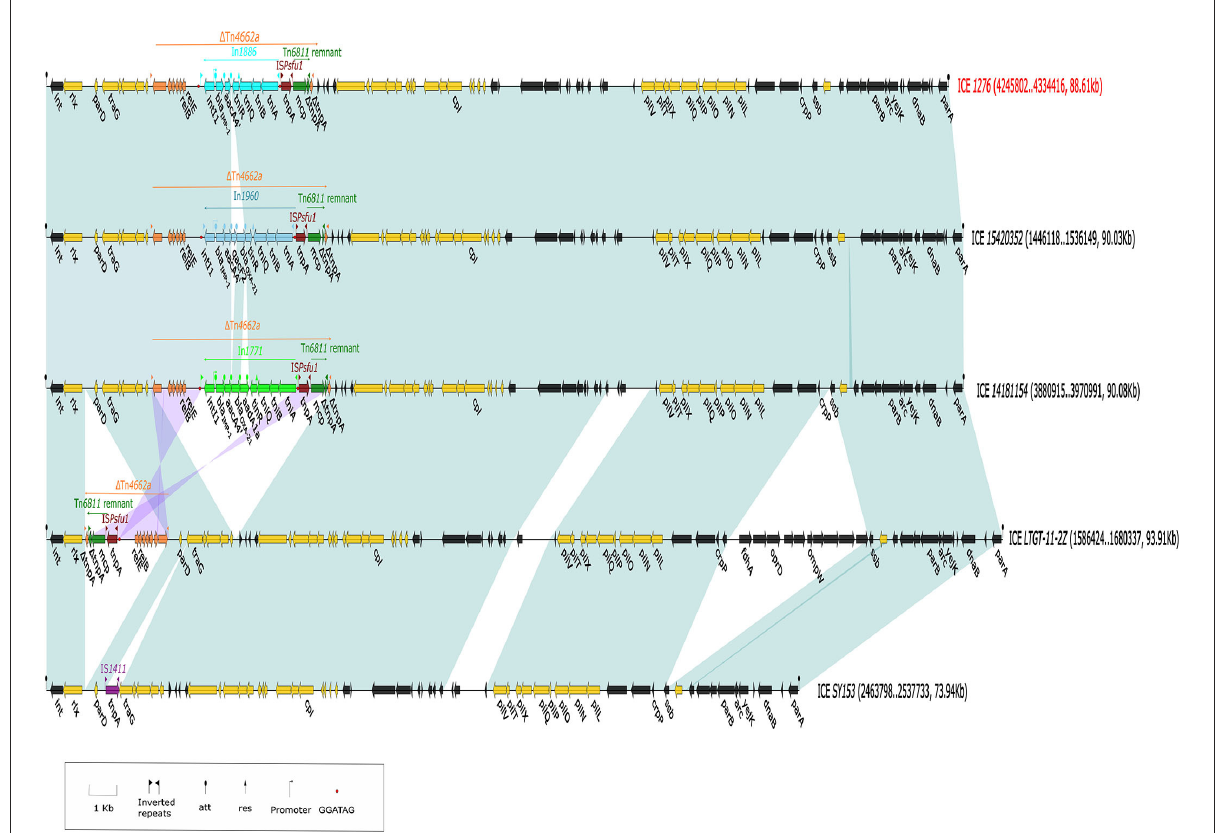
FIGURE2 Linear alignment map of integrative and conjugative elements (ICEs). The integration region is yellow, the backbone region is black, In 1886 is light blue, In 1960 is blue, In 1771 is green, Tn 4662a is orange, IS Psfu1 is dark red, Tn 6811 is dark green, and IS 1411 is purple. The solid red dot is the integron inverted repeat (IR) recognition sequence GGATAG, and the shaded region represents regions with > 90% nucleotide identity. Except for Pseudomonas putida SY153 ICE SY153 , the other ICEs were all Tn 4662a -derived structures. IS 1411 (ISL3 family) recognizes the 8 bp binding site (ATCAAAGG) on traG through IR, thereby inserting it into ICE SY153 and causing the binding site to form directed repeat (DR). Except for the Tn 4662a -derived structure in the ICE of Pseudomonas sp. LTGT-11-2Z that was inserted in the 257 bp site downstream of rlx after inversion, Tn 4662a -derived structures from other strains were inserted in the positive direction 296 bp upstream of the integrating conjugative element protein of the TIGR03757 family in these ICEs. The integron IR recognition site (GATAGG) was similarly present at 1,153 bp upstream of the res site on Tn 4662a (ICE LTGT-11-2Z ), but no integron was inserted. A 14.29-kb accessory module (dark pink) was also inserted 74 bp upstream of the ssb (single-strand DNA binding protein) in the backbone region of ICE LTGT-11-2Z and contains fdhA (formate dehydrogenase), oprD (outer membrane porin protein), and ompW (outer membrane protein). Alignment of ICE 1276 with ICE 14181154 from P. juntendi 14181154 and ICE 15420352 from P. putida 15420352 found that only the number of gene cassettes captured by the Tn 402 -like integron was different, and other structures were